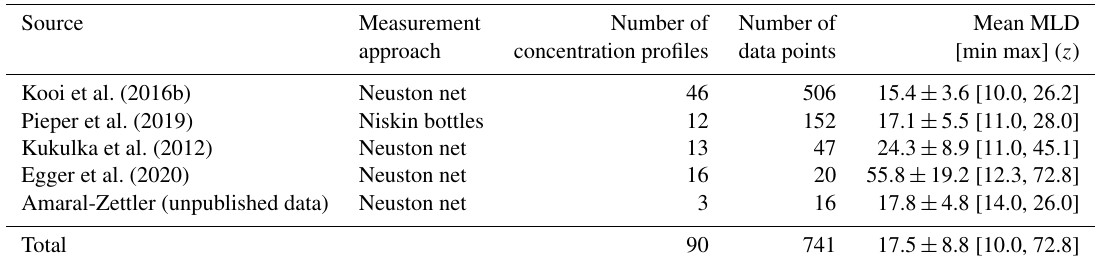
Table 1. Overview of the sources of field measurements of microplastic concentration profiles. The uncertainty in the mean MLD is the standard